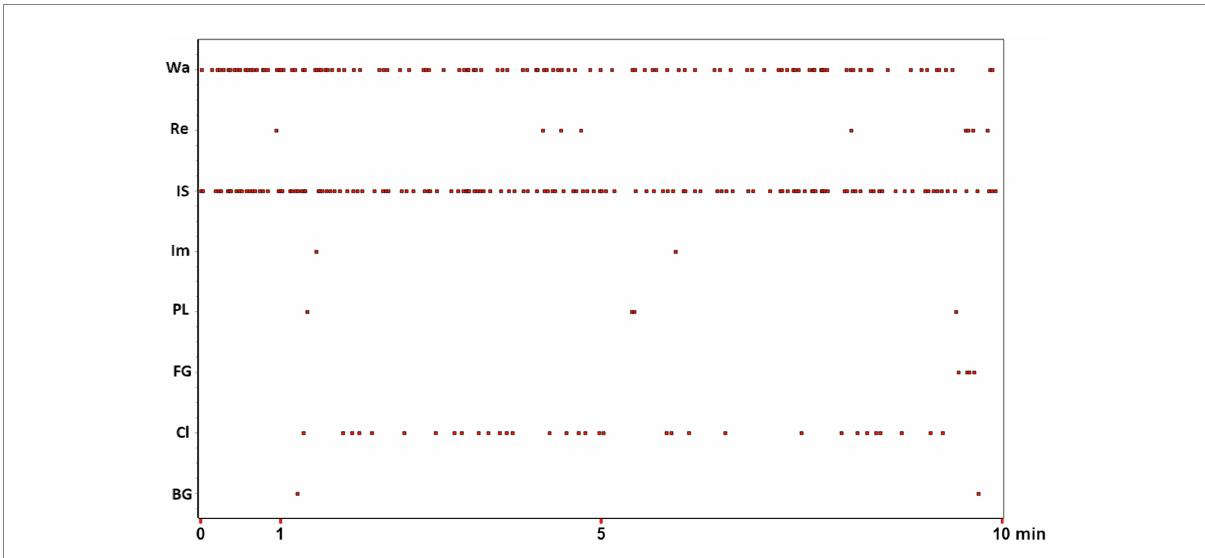
FIGURE 1 Event plot of 8 behavioral units (Y-axis) occurring during a 10-min (X-axis) observation window. For abbreviations of behavioral units on Y-axis see Table 1. Data from one subject taken from Casarrubea et al. (2020b). See text for details.